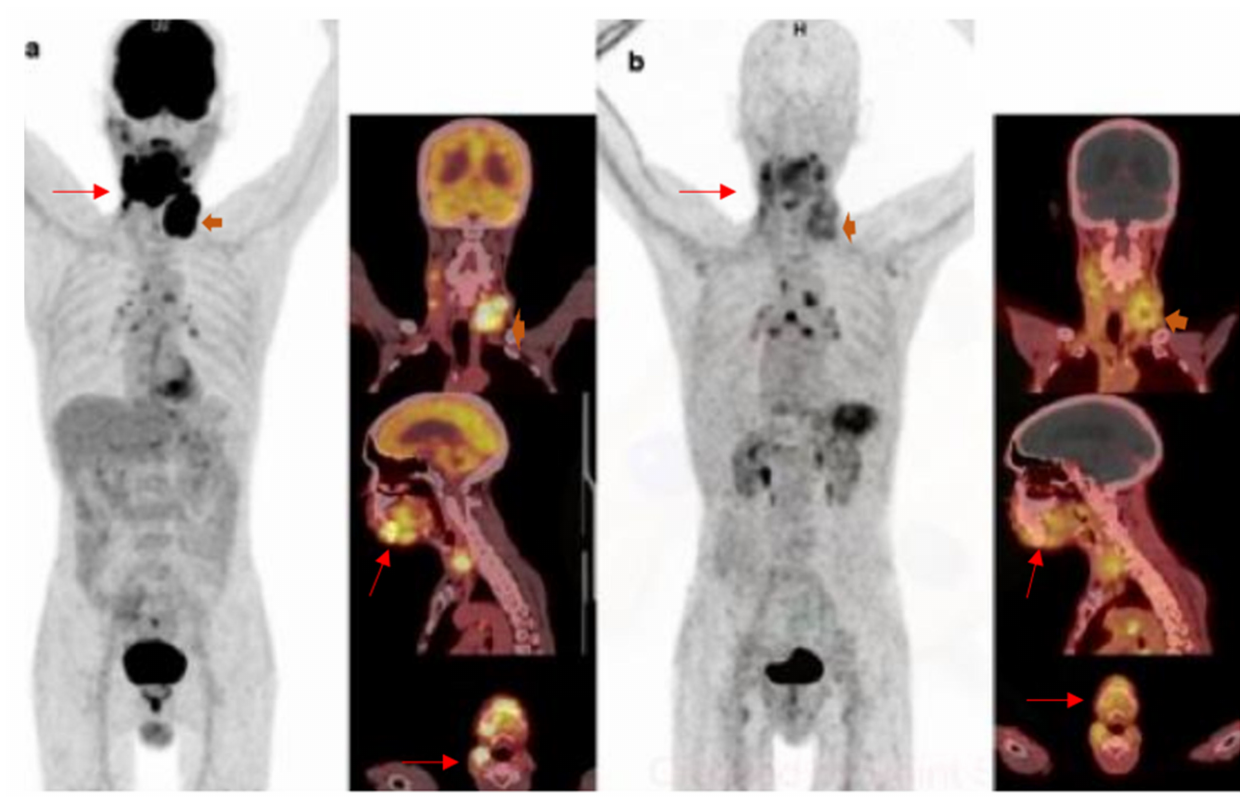
Figure 2. 18 F-FDG and 68 Ga-Pentixafor images of a 60-year-old female with squamous cell carcinoma of the oral cavity with intense uptake in the primary lesion and left cervical lymph node metastasis on 18 F-FDG ( a ). There was mild tracer accumulation on the 68 Ga-Pentixafor PET ( b ). Interestingly, the inflammatory mediastinal lymph nodes appear more intense on the 68 Ga-Pentixafor